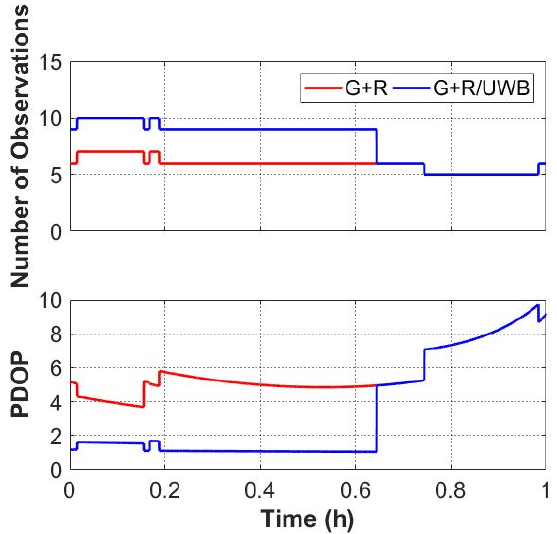
Figure 8. The number of observations ( top ) and the corresponding PDOP values ( bottom ) with a cutoff elevation angle of 40°.